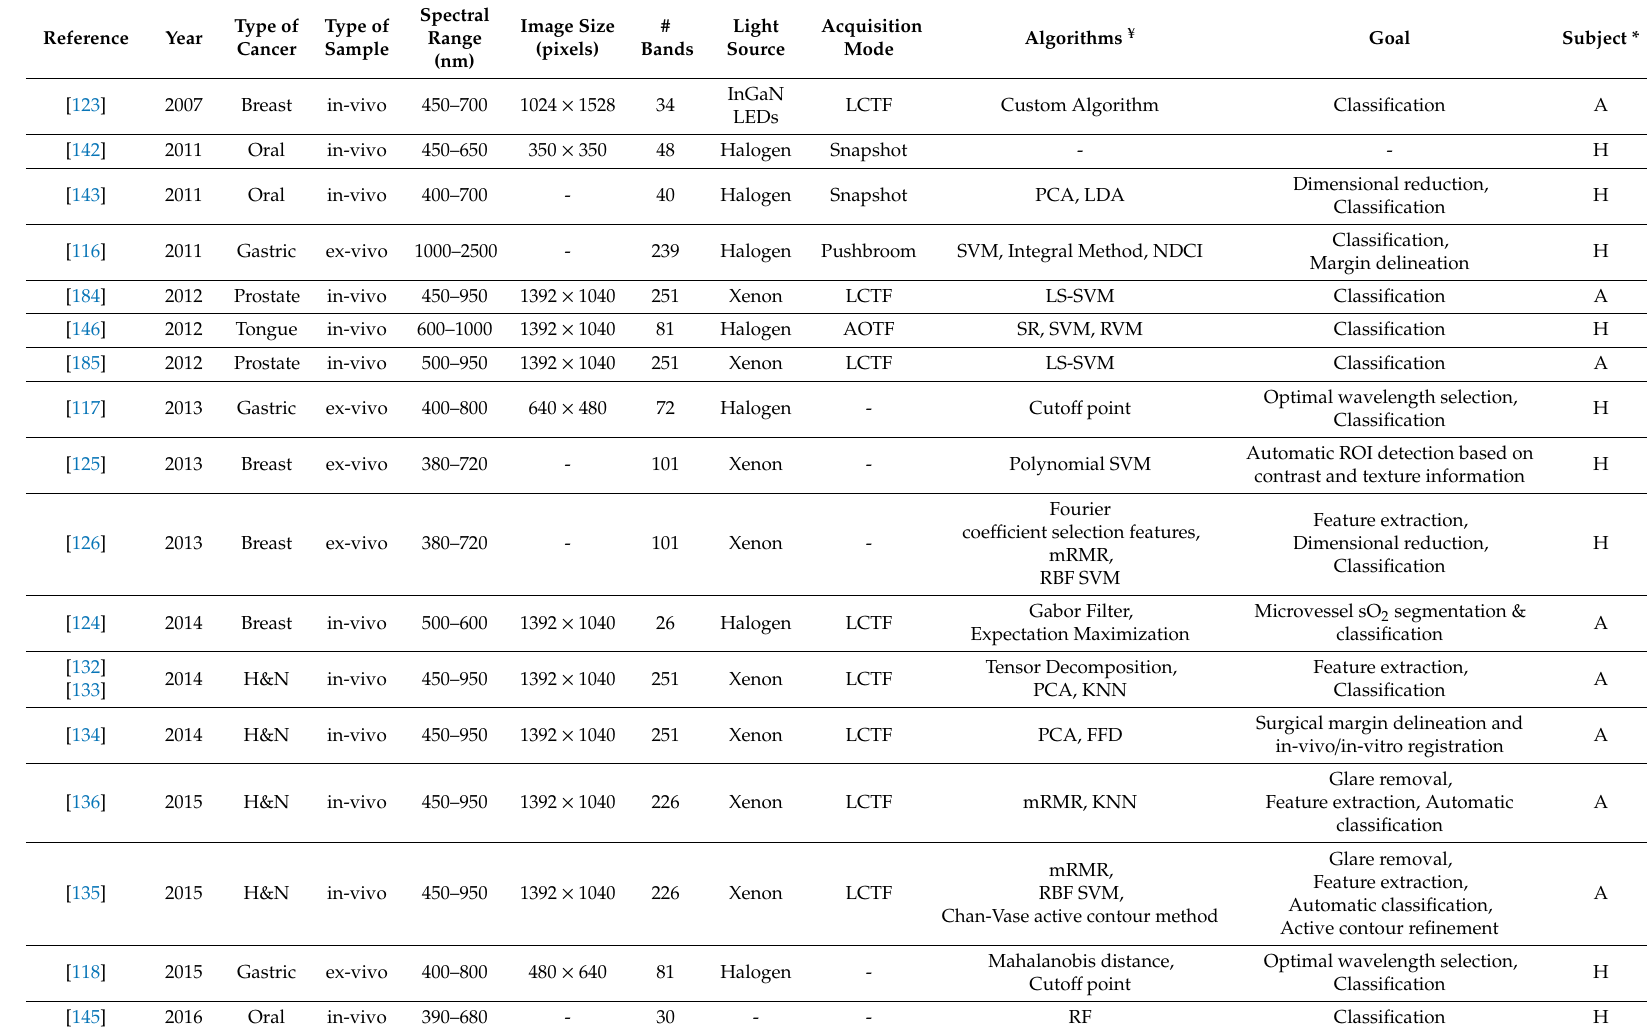
Table 1. Summary of the state-of-the-art studies on the use of HSI for cancer